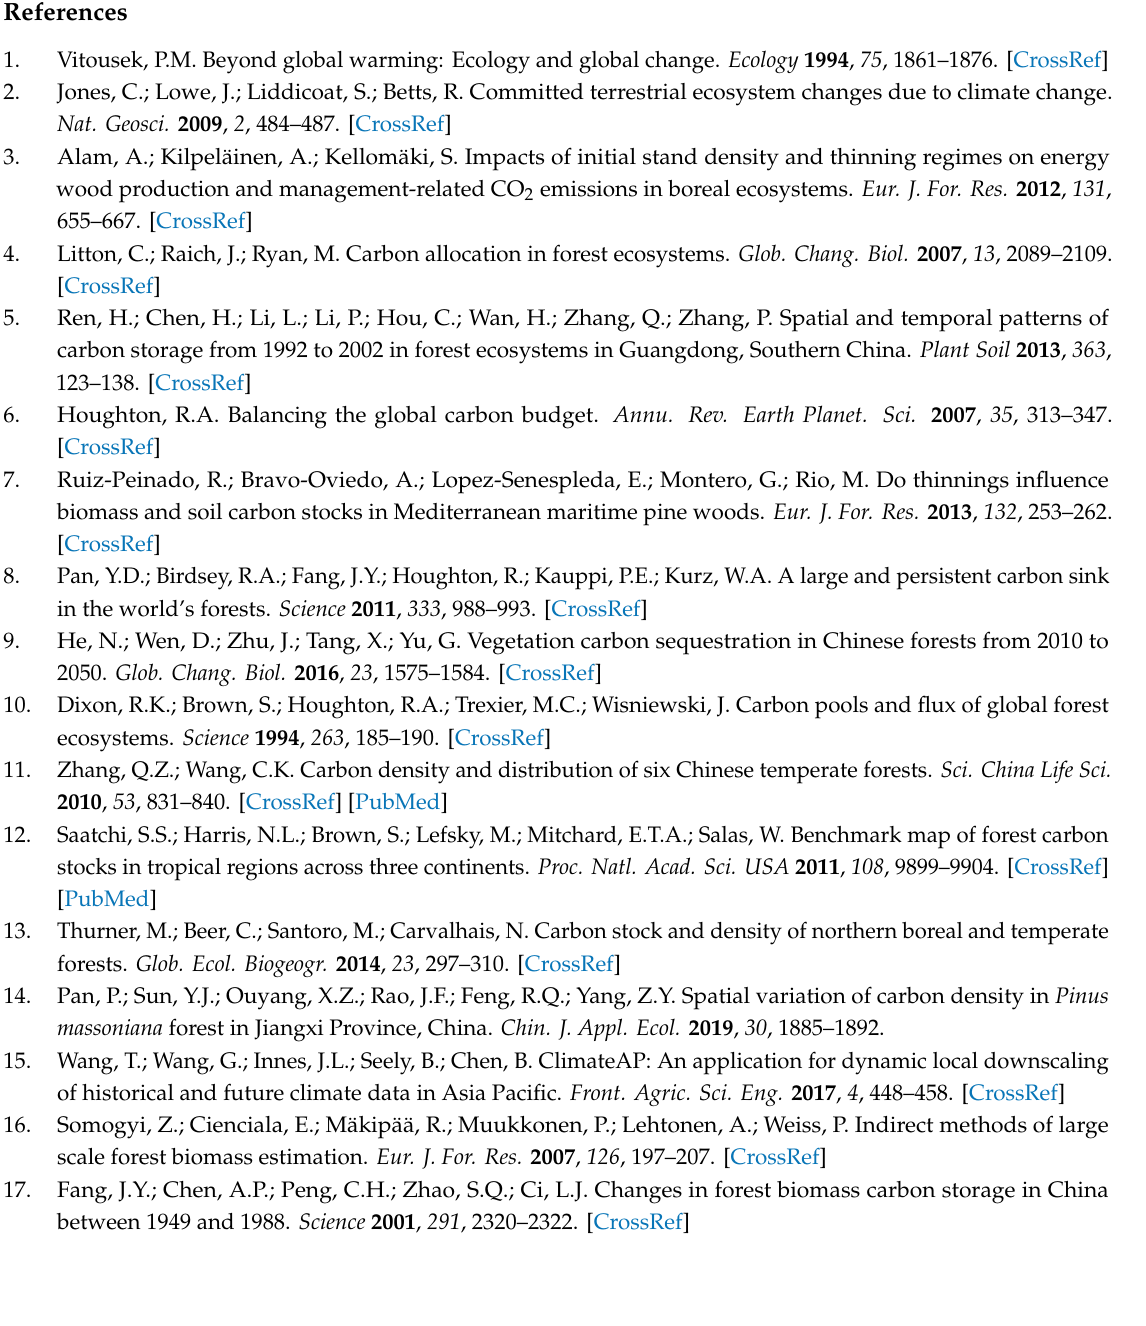
Table S1: Biomass models of di ff erent tree species; Table S2. Statistical performance indicators of di ff erent models; Table S3. Coe ffi cients of